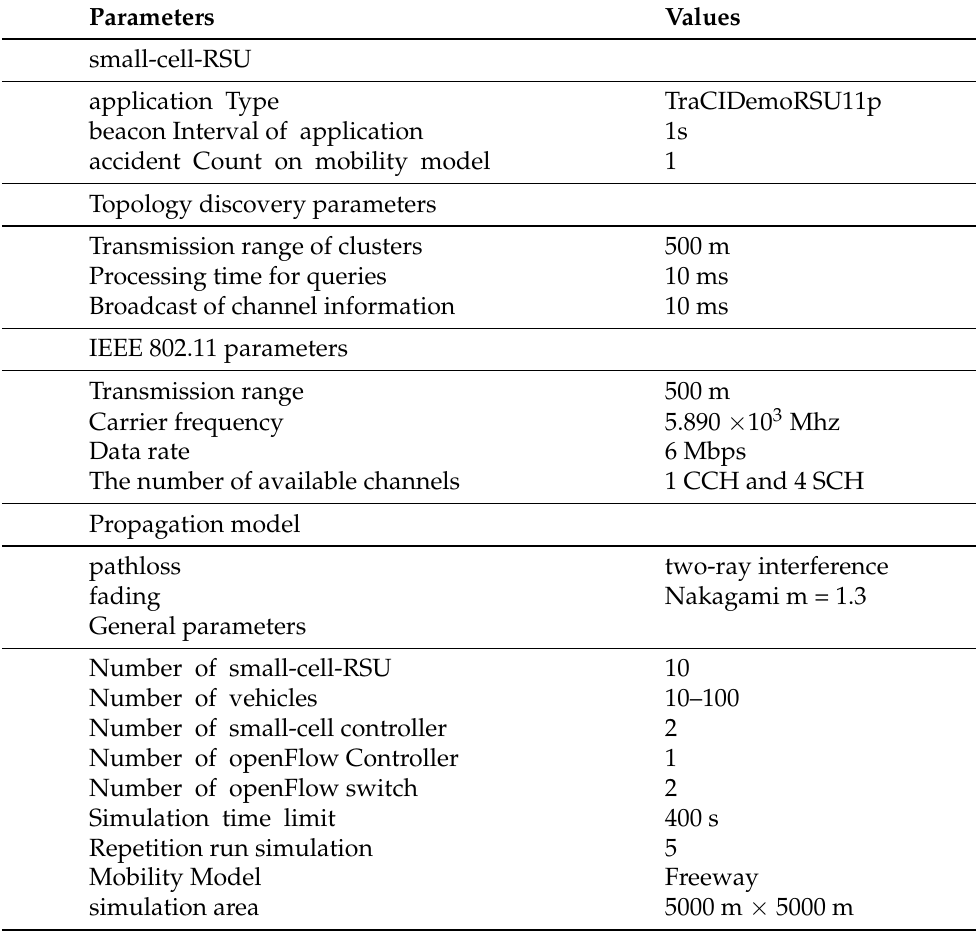
Table 2. Main simulation parameters and